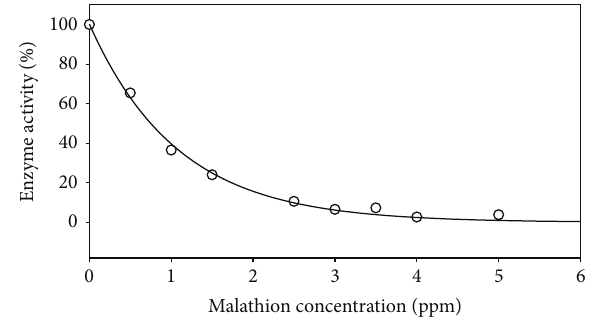
Figure 6: Relationship between inhibition of AChE activity and